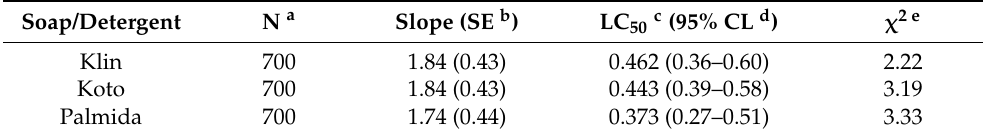
Table 3. Probit analysis and estimated median lethal concentration (LC 50 ) values of Klin